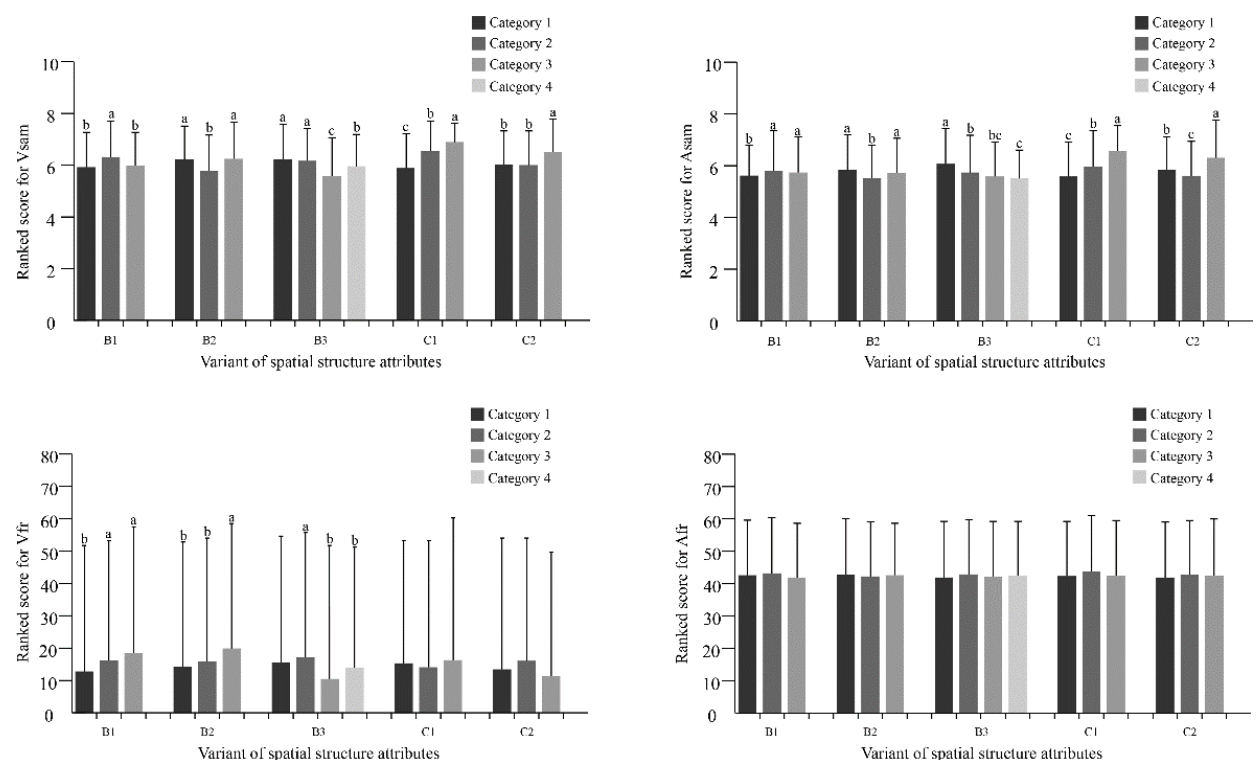
Figure 3. Post hoc test of the spatial structure attributes; Significant difference at the 0.05 level is shown by different letters (a,b and c).